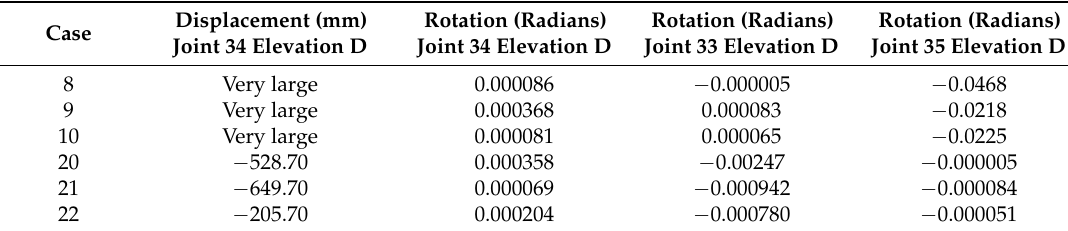
Table 9. Comparison between displacements and rotations when interior column D3 is removed.